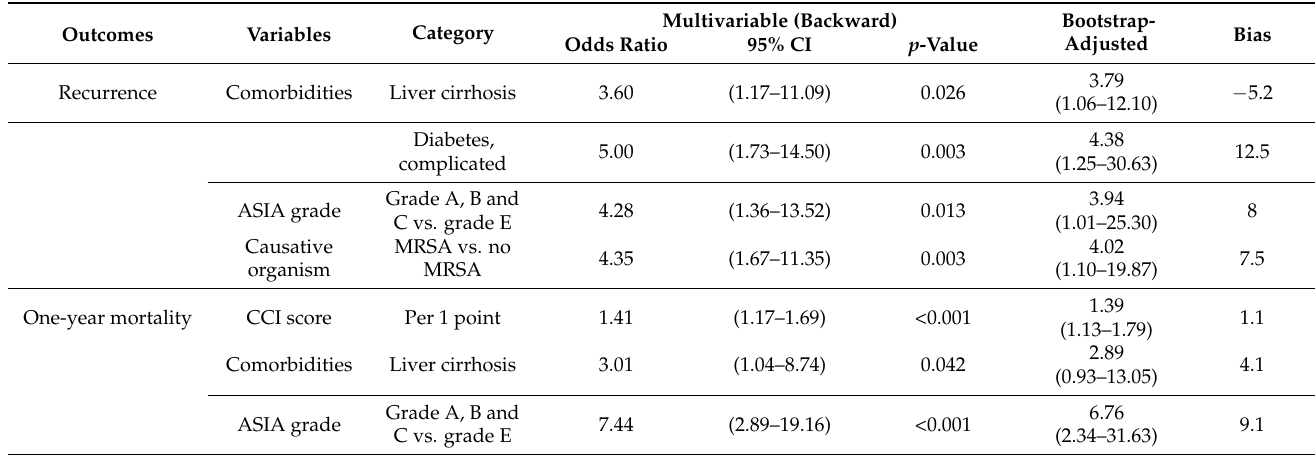
Table 4. Risk factors for recurrence and mortality in the surgical cohort: multivariable analysis.